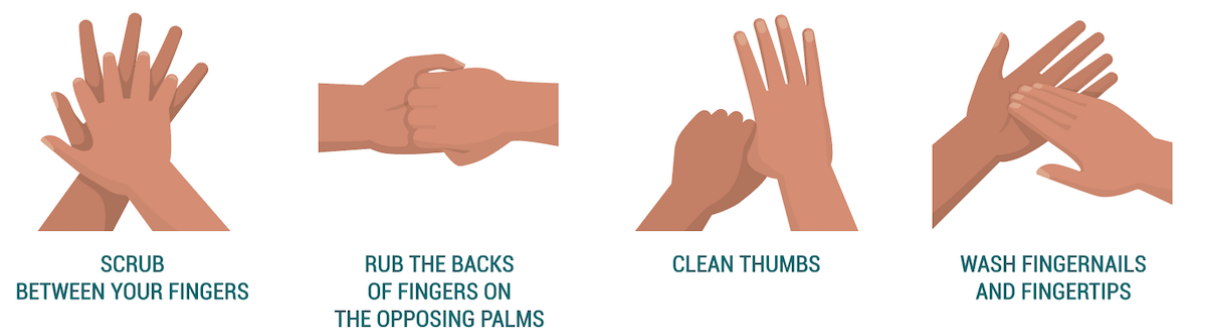
Figure 3. An example of the progression of vectors used in the handwashing